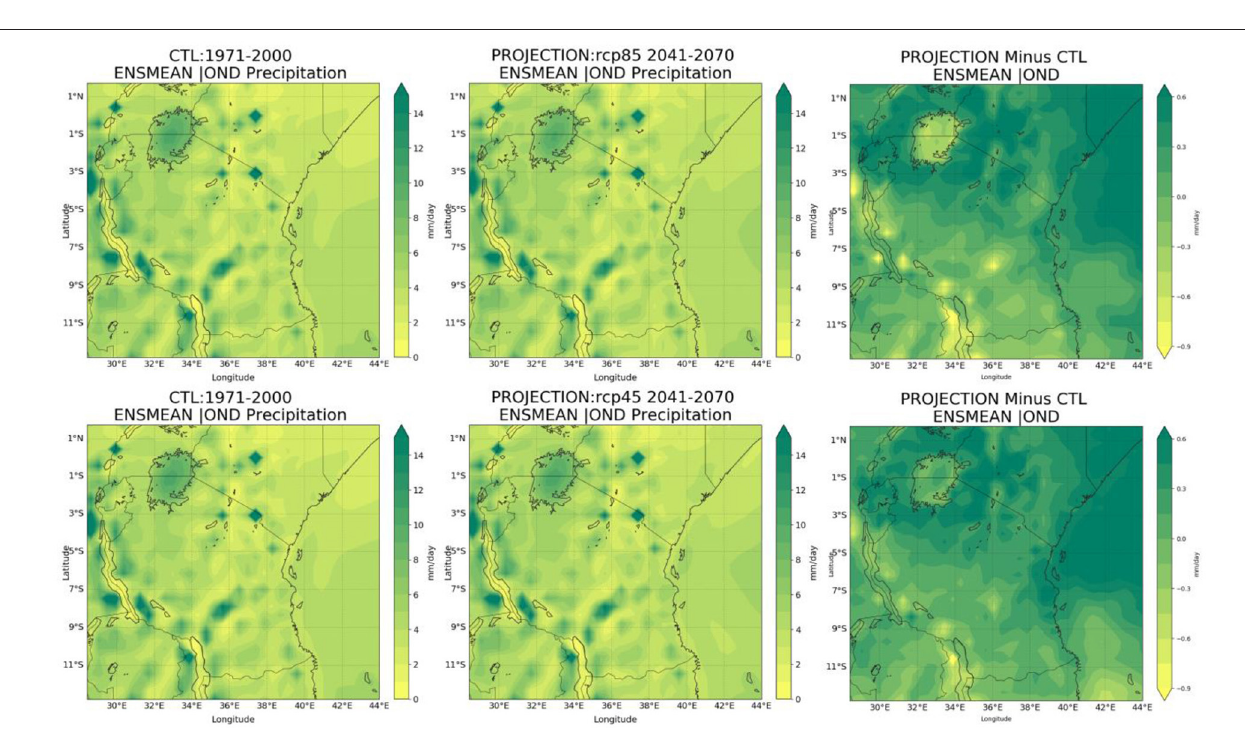
Frontiers in Environmental Science | www.frontiersin.org